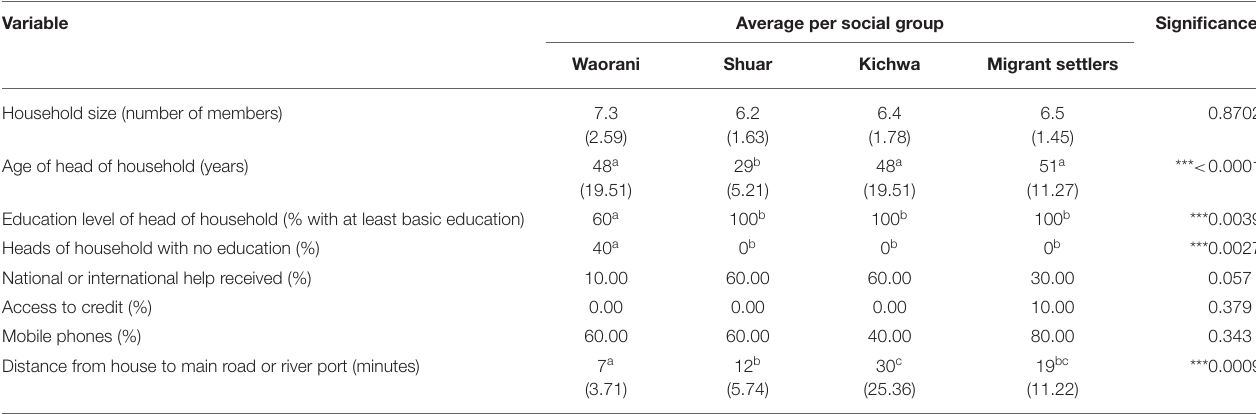
TABLE 3 | Sociodemographic characteristics of the four social groups evaluated in the Yasuní Biosphere Reserve, Amazon region of Ecuador.